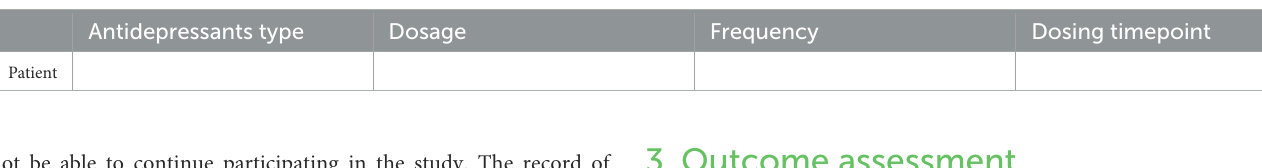
TABLE 2 The records of patients with PPD taking